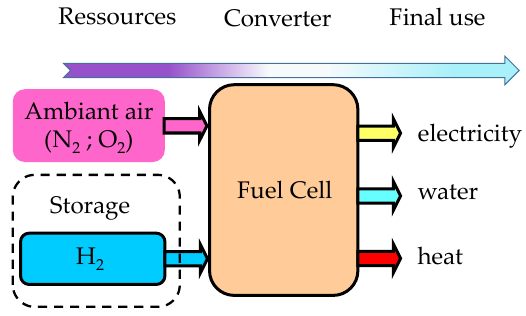
Figure 3. Fuel cell systems (FCS) functional principle.